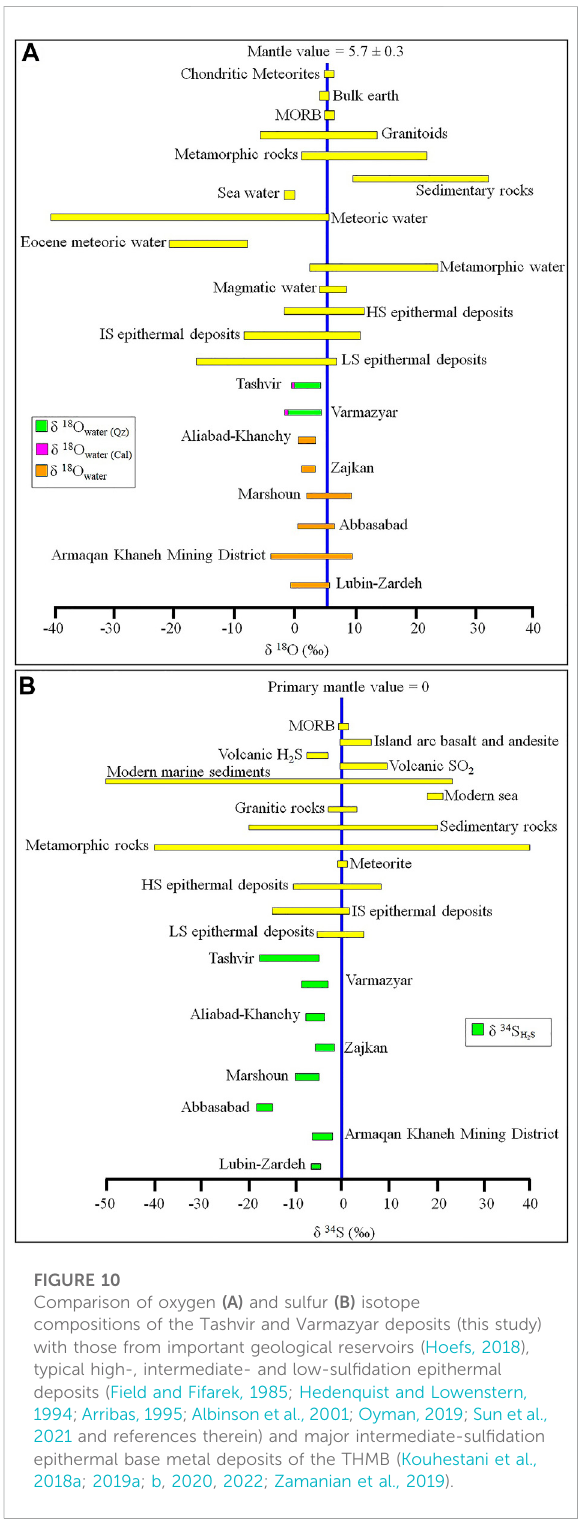
Frontiers in Earth